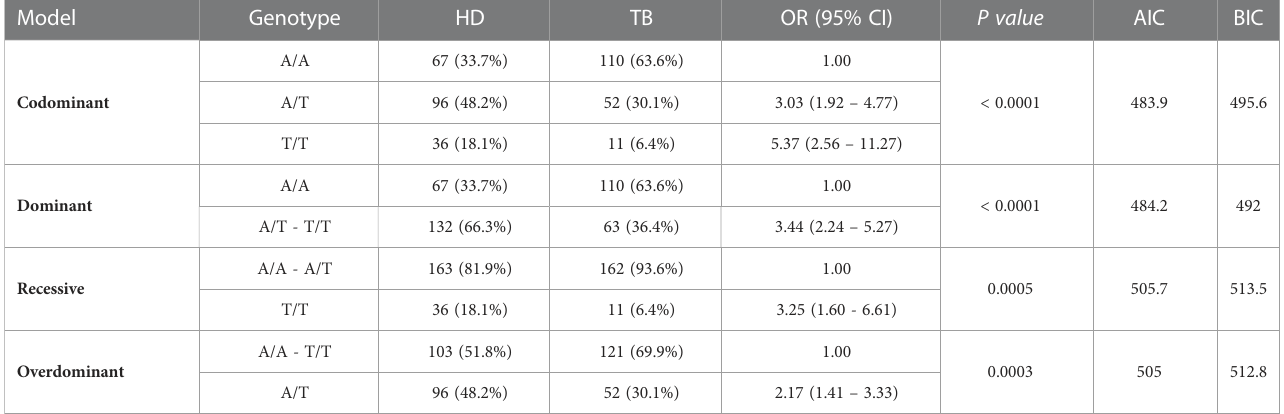
TABLE 3 Association studies of IFN- g gene (+874 A/T) with the development of active tuberculosis.